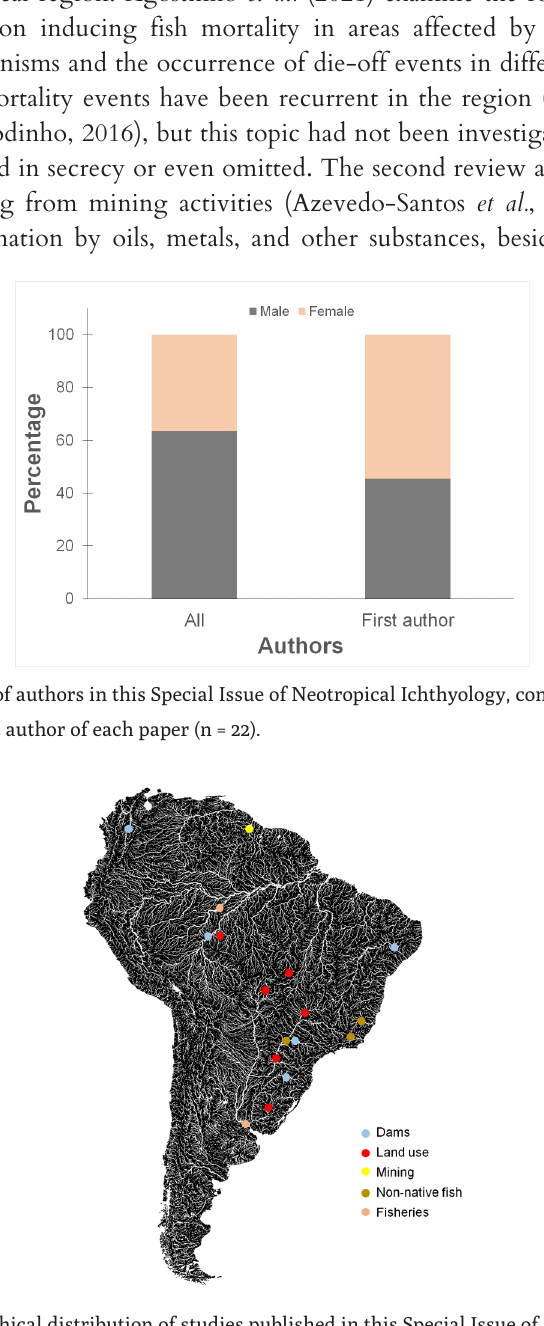
FIGURE 2 | Geographical distribution of studies published in this Special Issue of Neotropical Ichthyology. Colors indicate the type of impact. Five papers are not shown in the map, because they covered large spatial extents ( i.e. , whole basins or the Neotropical